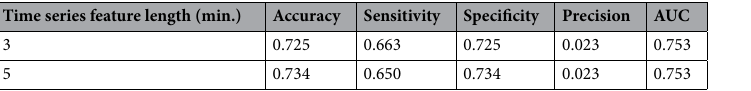
Table 2. Comparison of the performance when the length of the time series feature used for prediction was set to either 3 or 5 min. For all evaluation metrics, the performance was similar, and no significant differences were observed using the t -tests.